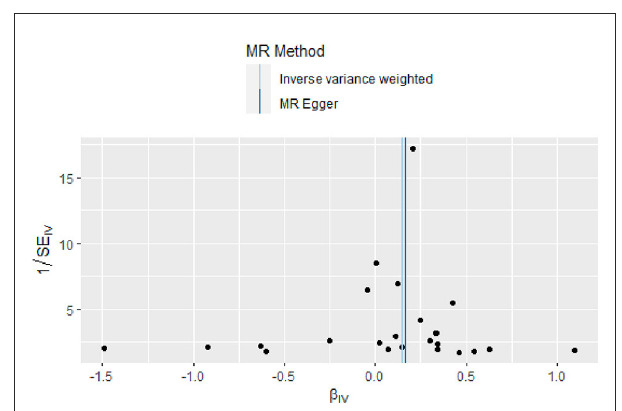
FIGURE5 Funnel plot of the causal relationship between omega-3 fatty acids and generalized epilepsy as assessed by MR